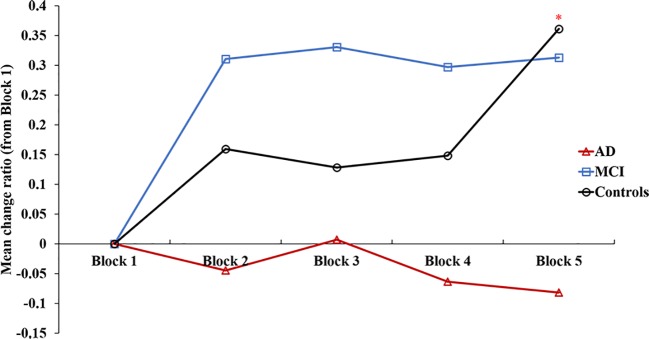
The change ratio of making advantage choices in an Iowa gambling task for 1-5 blocks. Controls selected more advantageous choices over time, whereas the MCI did not differ, and AD chose advantageous choices more randomly over the task. *vs Block 2, Block 3, Block 4 p < 0.05.